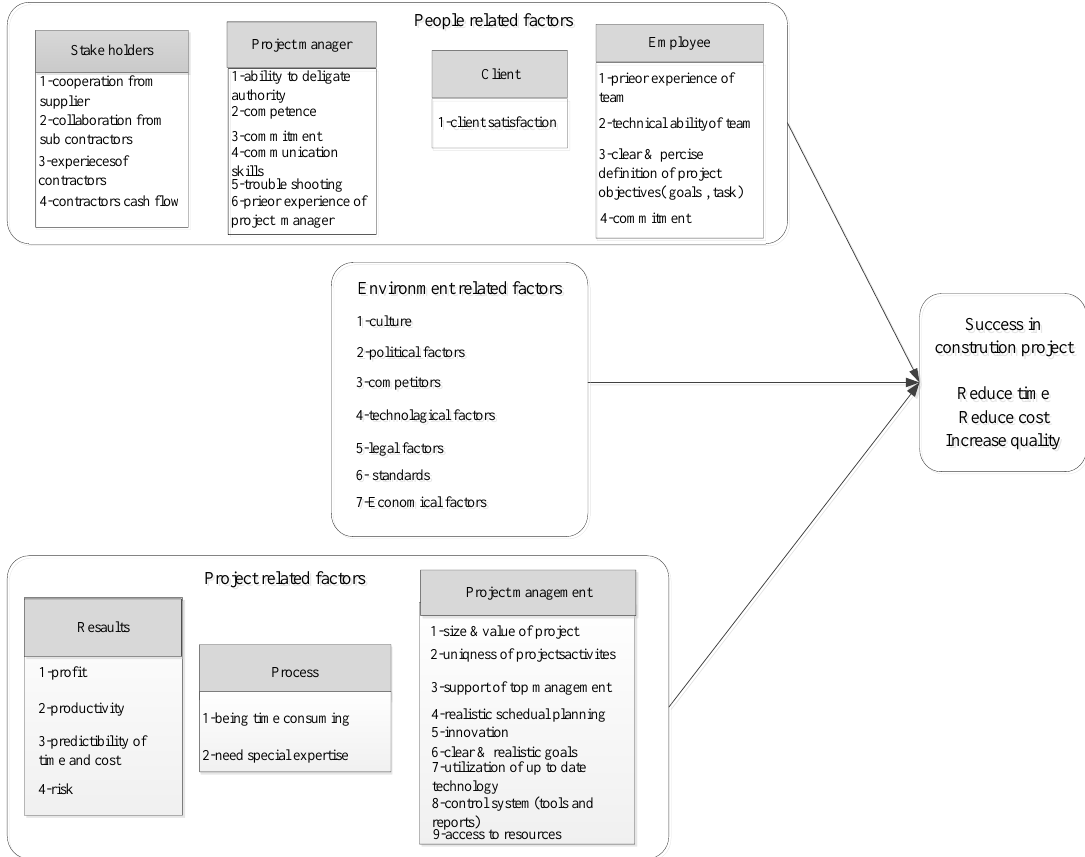
Figure 1. The Proposed Frame Work of CSFs Model in Construction